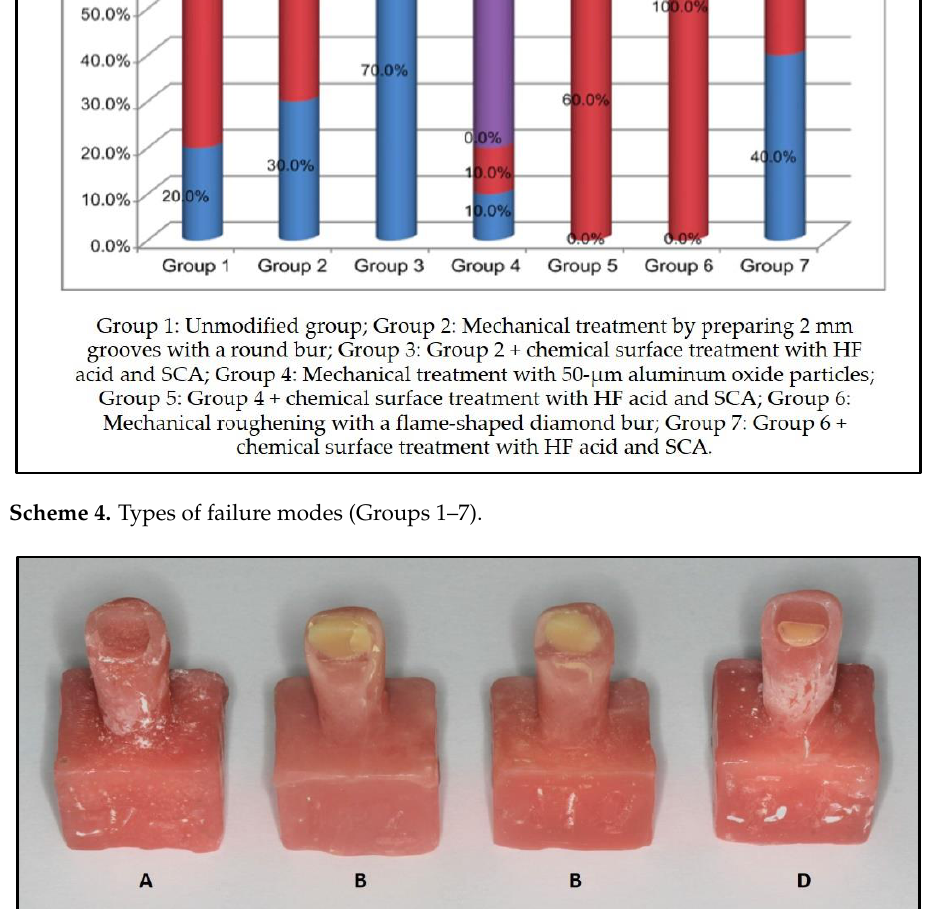
Figure 6. Types of failure modes: ( A ) adhesive, ( B ) cohesive in tooth, ( C ) cohesive in tooth and denture base, ( D ) mixed: adhesive and cohesive.